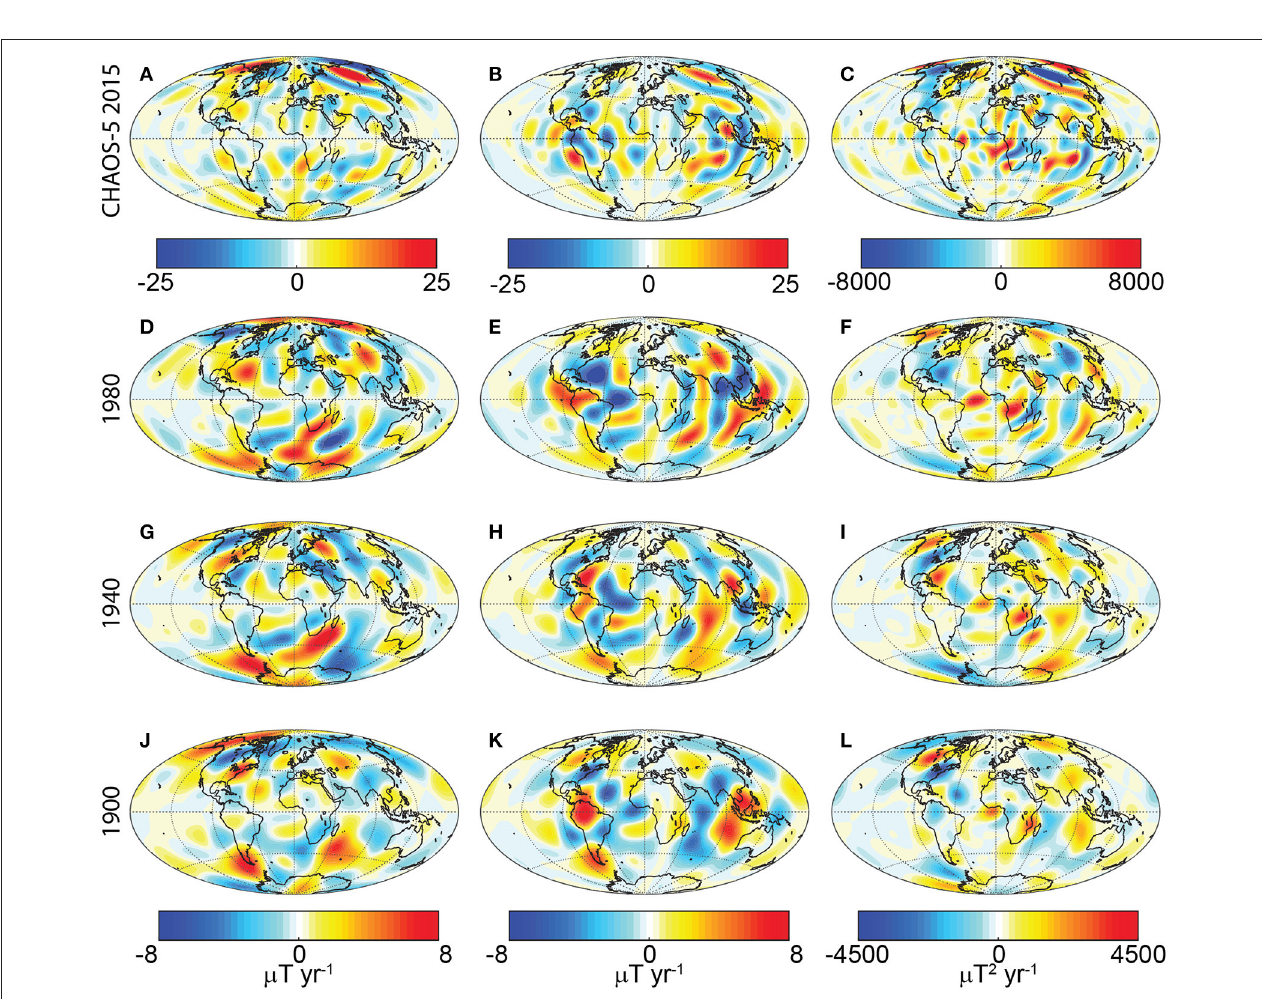
FIGURE 5 | Integrands of ˙ m z (A,D,G,J) , ˙ m e (B,E,H,K) , and ˙ E b (C,F,I,L) for CHAOS-5 in 2015 (A–C) and gufm1 in 1900 (D–F) , 1940 (G–I) , and 1900 (J–L) .